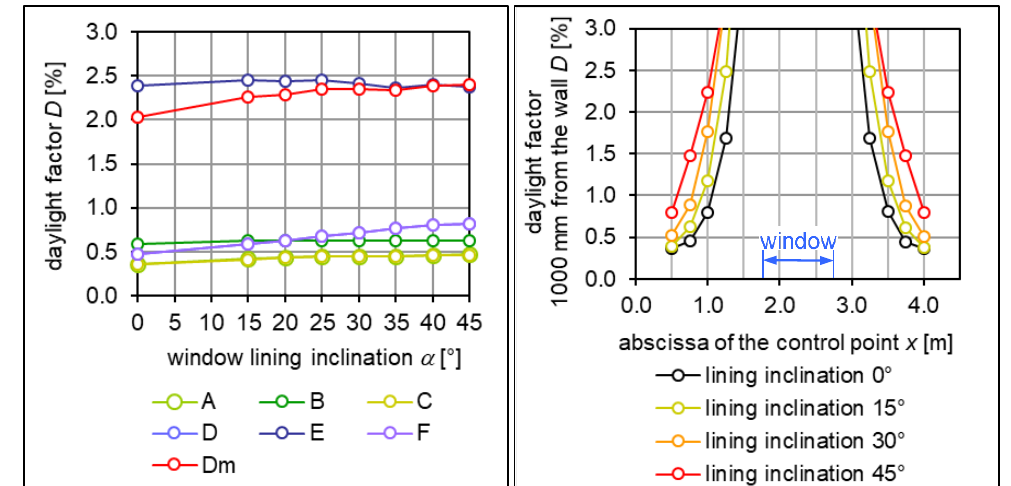
Figure 15. The results of the daylight calculation as a function of the lining inclination. The daylight factor at selected control points (see Figure 7) and the mean value ( D m ) ( left ) and daylight factors in the line of control points at a distance of 1 m from the external wall ( right ).